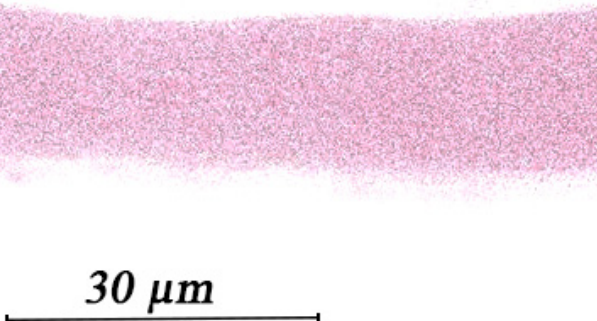
distribution of silver cations throughout the thickness of the crosslinked polymer (Figure 2).